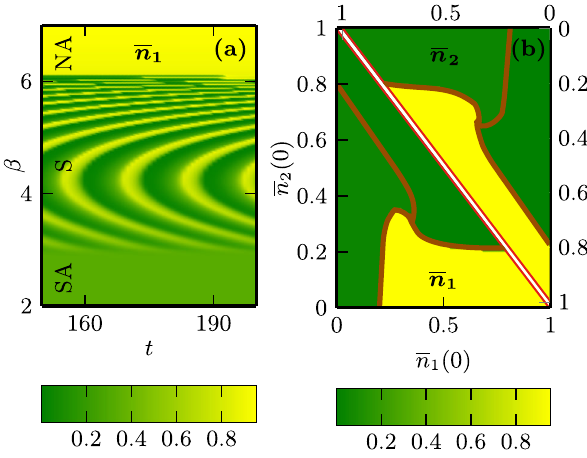
FIG. 4. Illustration of the occupation probability ¯ n 1 as a function of β and t for f ¼ 1 . 0 in (a), while (b) shows the occupation densities ¯ n 1 in the lower-left triangle and ¯ n 2 in the upper-right triangle as a function of all initial conditions at ¯ n 1 ð 0 Þ and ¯ n 2 ð 0 Þ at time t ¼ 10 3 and for β ¼ 7 . 0 . The initial condition underlying the plots in (a) is ½ ¯ n 1 ð 0 Þ ¼ 1 ; ¯ n 2 ð 0 Þ ¼ 0 (cid:2) . The times are chosen such that the system has reached either the unique FP in the symmetric asynchronous phase (SA), the stable LC in the synchronous phase (S), or one of the three nonsymmetric FPs in the nonsymmetric asynchronous phase (NA). The triple points defined by the intersecting contour lines in (b) correspond to the symmetric unstable FP present in the NA